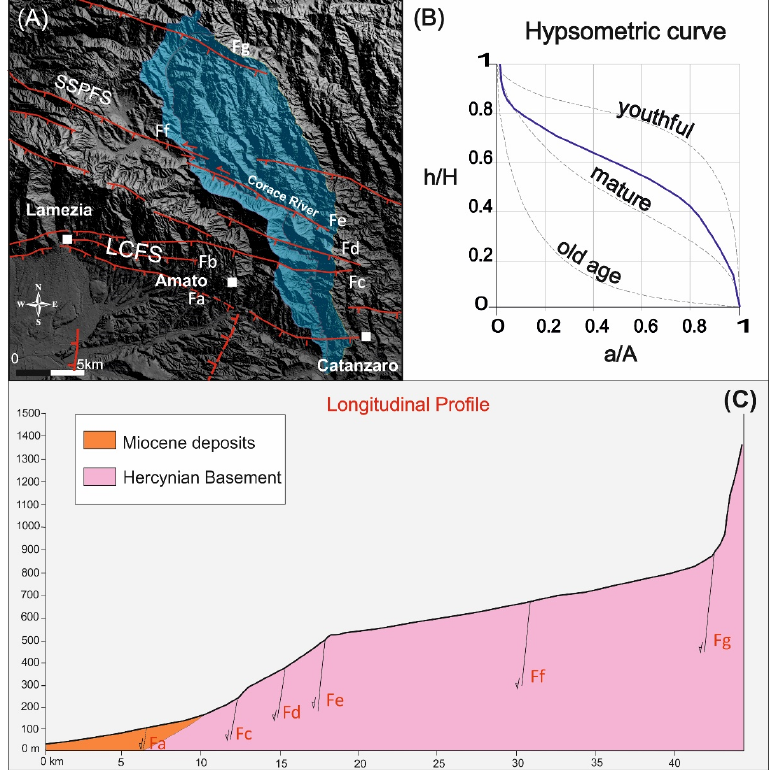
Figure 8. ( A ) DTM hillshade showing the C2 sub-basin and faults crossing the area. ( B ) Hypsometric curve of the C2 sub-basin. ( C ) Longitudinal profile of the C2 sub-basin and faults. Fault activity and relative motions were validated (see Section 5) by published geodetic data [9] and instrumental seismicity (http://terremoti.ingv.it/, accessed on 15 July 2022, see also [54]). Table 1. Hierarchical parameters and geomorphic indexes.